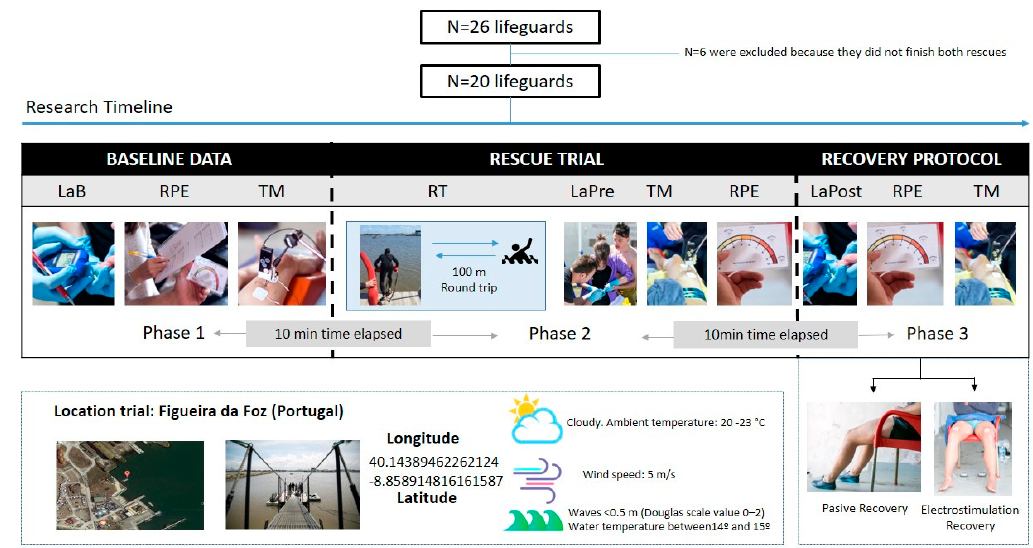
Figure 1. Trial flow chart. LaB = Lactate (Baseline), RPE = rate of perceived exertion, TM = tensiomyography, RT = rescue time, LaPre = Lactate Pre-recovery protocol, and LaPost = Lactate Post-recovery protocol.